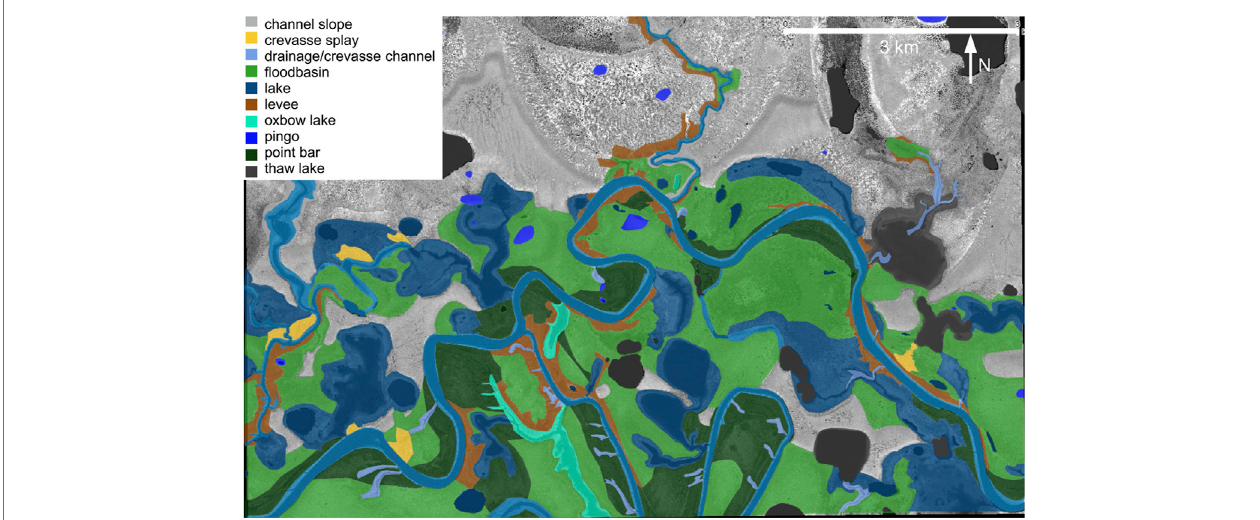
FIGURE8| Geomorphologyoftheactive fl oodplain(ARF)withsubunits.Backdrop:LowerhalfofWorldview2019imagein Figure4 .Unclassi fi edareasaretheRT (old river terrace), YR and DTLB areas. WorldView © 2019 MAXAR.